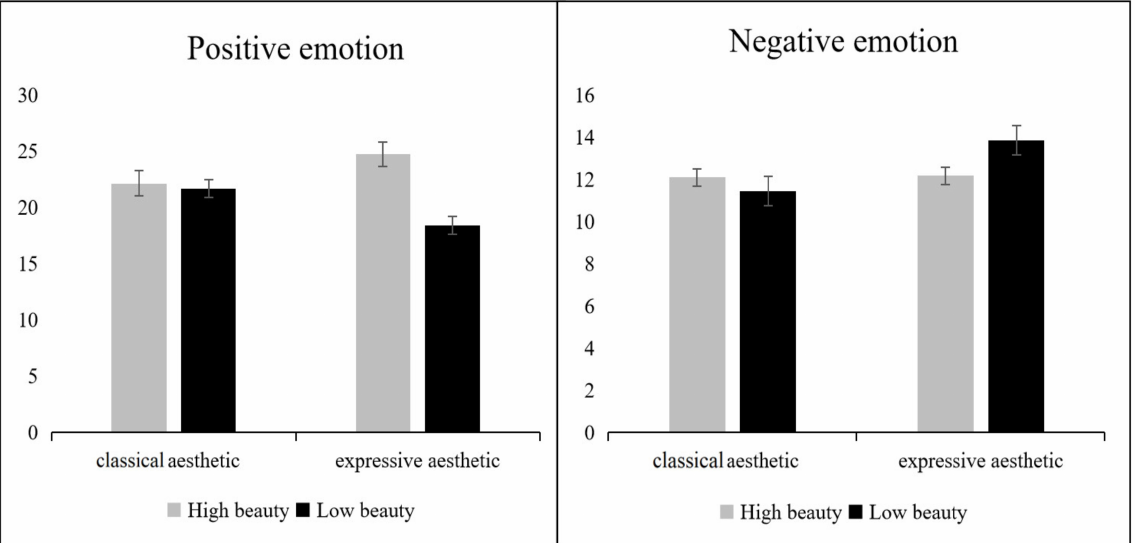
Figure 8. Positive emotions ( left ) and negative emotions ( right ) for different pattern types with different beauty levels of plates. Error lines represent 95% confidence